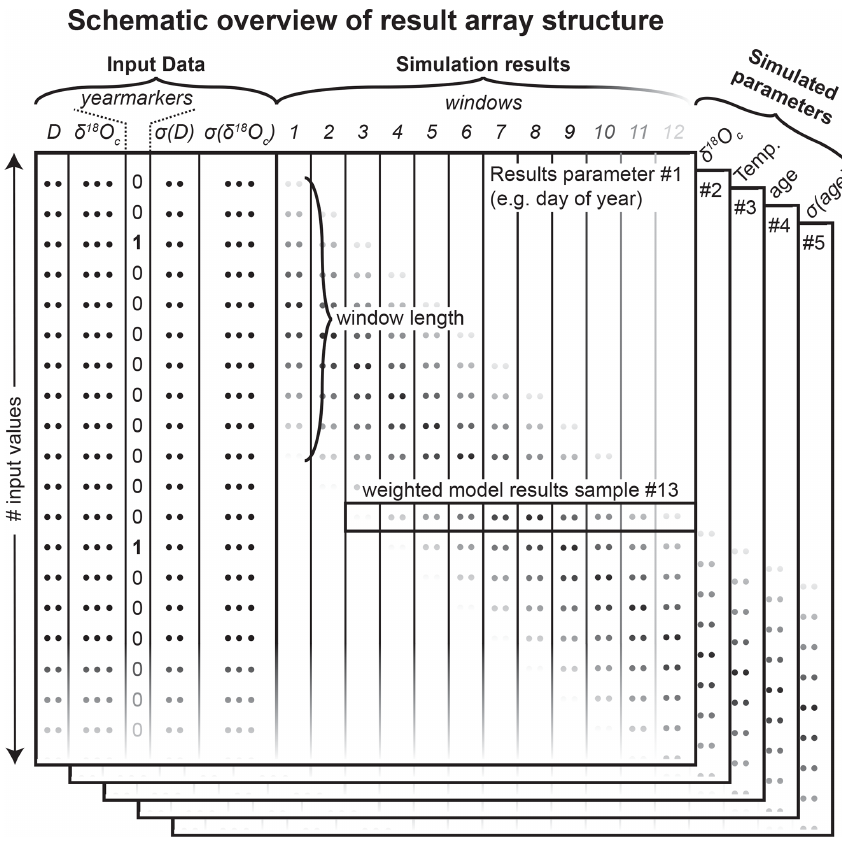
Figure 3. Schematic overview of the structure of the result array in which ShellChron stores the raw results of each model window. Data are stored in three dimensions: the sample number (rows in the figure), the window number (columns in the figure), and the number of modeled parameters (represented by the stacked table “sheets” in the figure). Note that the first five columns of each sheet represent the user-provided input data (see example in SI2) and that the model result data start from column 6. The window length is determined by the user-provided indication of year transitions (column 3). Rows of dots in the figure are placeholders for (input or result) values. Shading of these dots in the window columns indicates differential weighting of modeled values as a function of their location relative to the sliding window. The horizontal box shows how these weighting factors within each sample window (in vertical direction) result in weighting of different estimates of modeled parameters for the same data point (in horizontal direction). The shading of input data and window number towards the bottom and right edge of the figure, respectively, indicates that the number of input values (and thus simulation windows) is only limited to the length of the input table and may therefore continue indefinitely (at the expense of longer computation times; see Fig. 8 in the “Model performance”